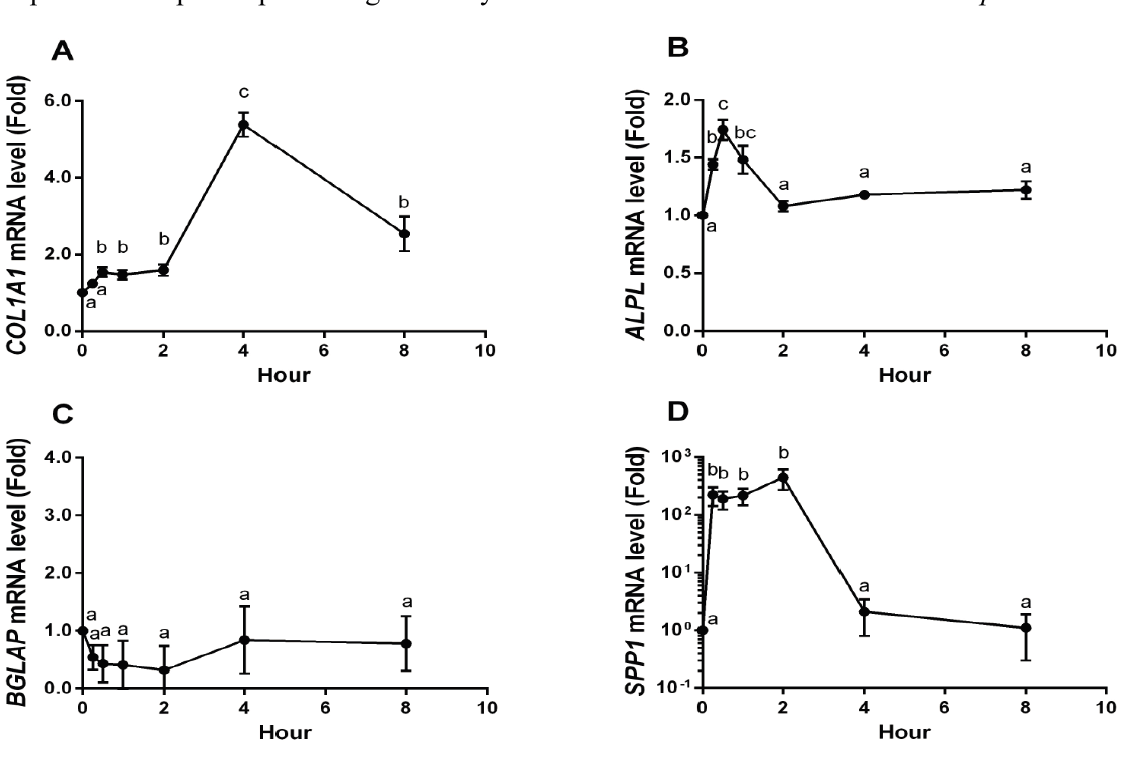
Figure 5. Effects of short term YPEP treatment on osteogenic gene